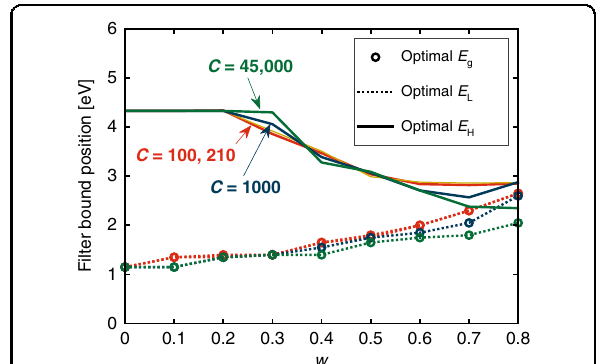
Fig. 5 Optimal PV bandgap energy and corresponding optimal fi lters for different w . Energies (in eV) can be converted to wavelengths (in nm) via λ (nm) = 1240/ E (eV), e.g., 4.4eV ≈ 280